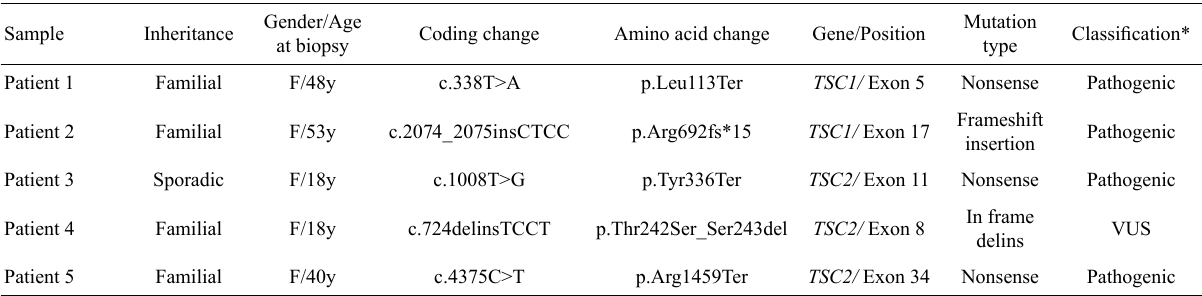
Table 1 ‒ Mutation analysis of TSC patients included in this